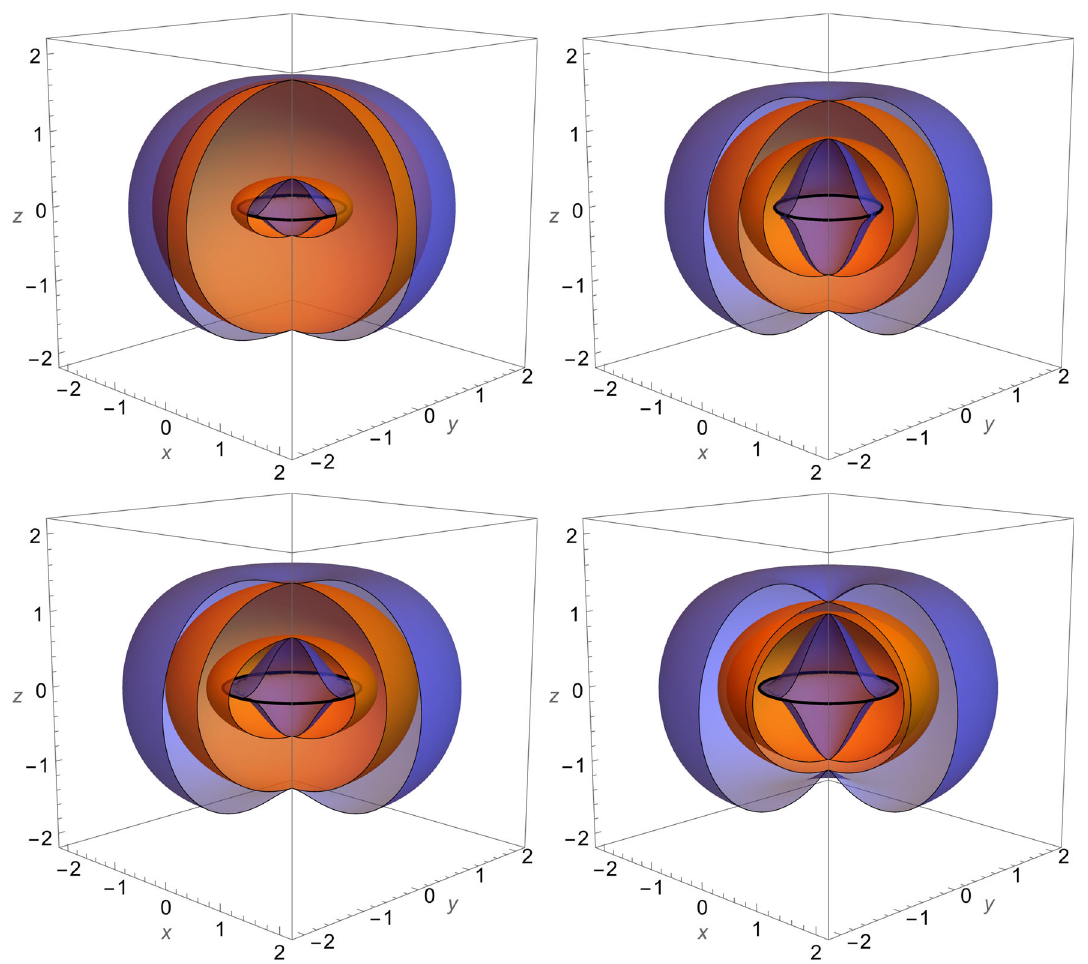
Fig. 3 Plot showing the ergospheres of rotating hairy black holes. black ring is the central singularity. SLS and horizons meet only at z - axis. Top right and left: ( a = 0 . 7 M , Q = − 0 . 2 M ) and ( a = 0 . 7 M , The coordinate transformation from Boyer–Lindquist coordinates Q = − 0 . 7 M ); Bottom right and left: ( a = 0 . 9 M , Q = − 0 . 1 M ) and (lim M → 0 ) { r , θ, φ } to Cartesian coordinates { x , y , z } is given by √ √ x = r 2 + a 2 sin θ cos φ , y = r 2 + a 2 sin θ sin φ , z = r cos θ . ( a = 0 . 9 M , Q = − 0 . 27 M ) Blue surfaces are for the SLS, orange surfaces are for the horizons and